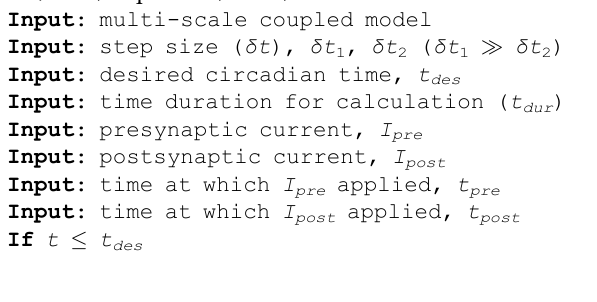
Algorithm-1 : Solve the multi-scale coupled model at desired circadian time to get SFR, LTP, LTD, acquisition, recall, and extinction